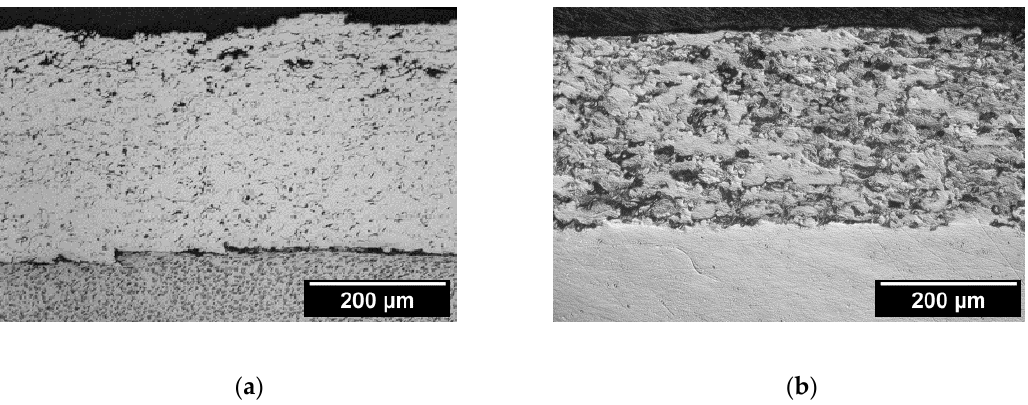
Figure 11. Examples of the microstructure of the Ni–5%Al alloy coating etched with 4% HNO 3 . ( a ) After thermal spraying, the roughness of the coating was Ra = 13.3 µ m and ( b ) after burnishing (roller: ϕ 50 mm), the roughness of the coating was Ra = 0.2 μ m.